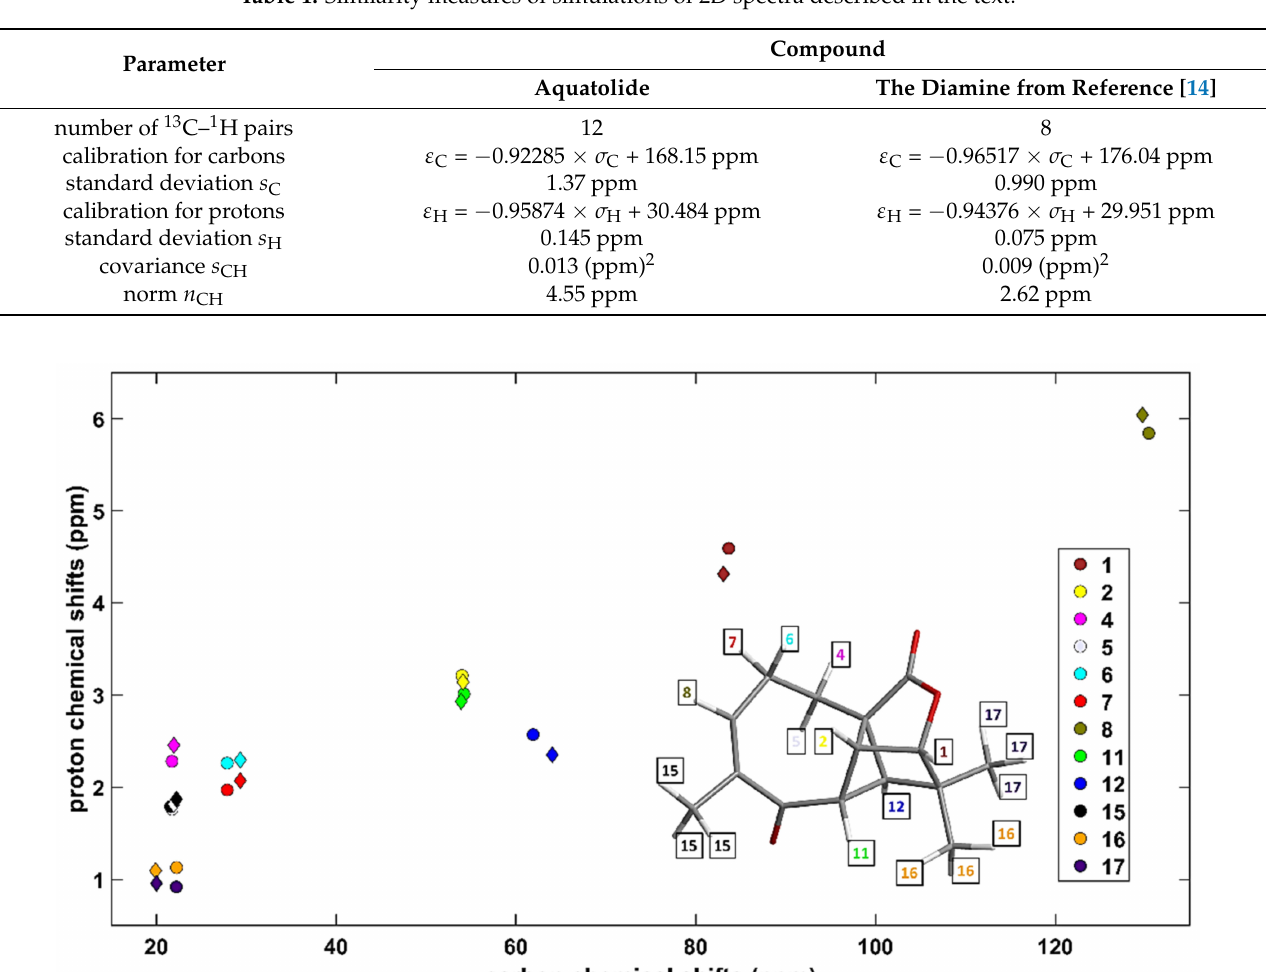
Table 1. Similarity measures of simulations of 2D spectra described in the text.